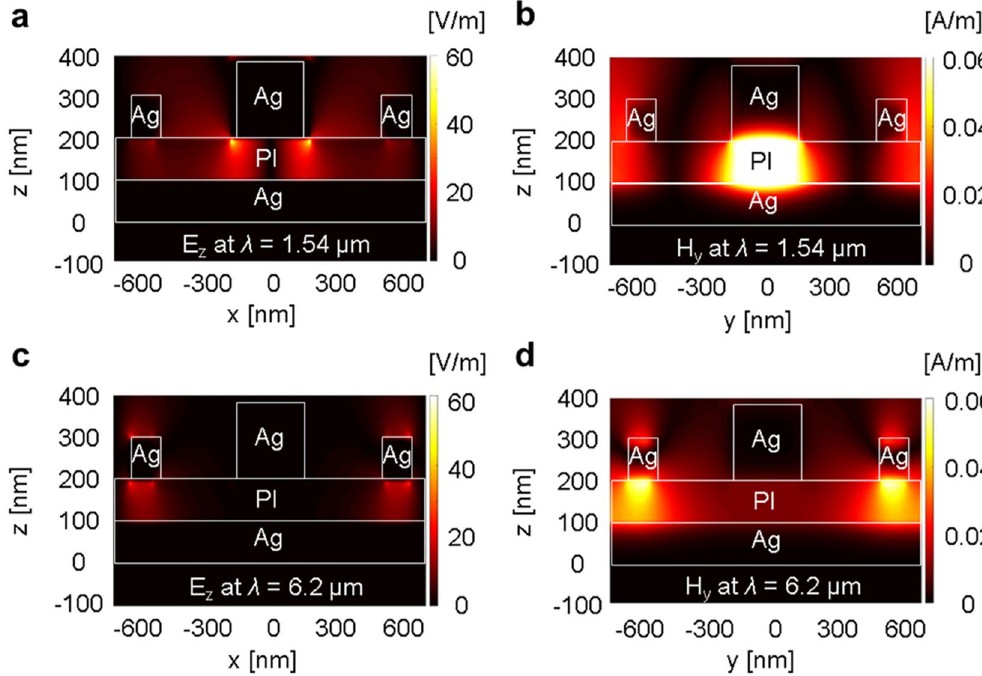
Figure 3. Electric and magnetic field distributions. ( a ) Electric field distribution E x and ( b ) magnetic field distribution H y in cross sections of the MIM structure when SPPs and MPs were simultaneously excited by the disk array at a wavelength of 1.54 μ m. ( c ) E x and ( d ) H y in cross-sections of the MIM structure when MPs were excited only by the rings at a wavelength of 6.2 μ